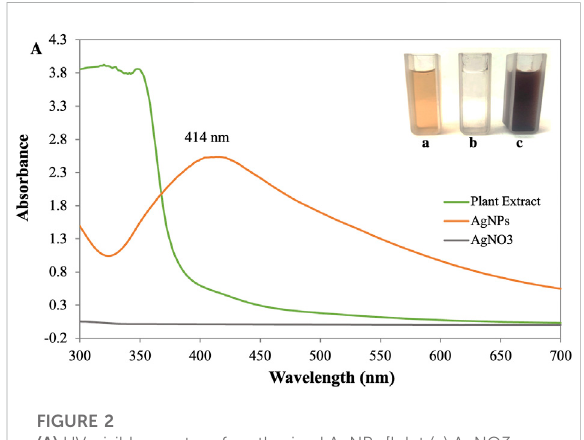
FIGURE 2 (A) UV-visible spectra of synthesized AgNPs [Inlet (a) AgNO3 (b) Plant Extract (c)